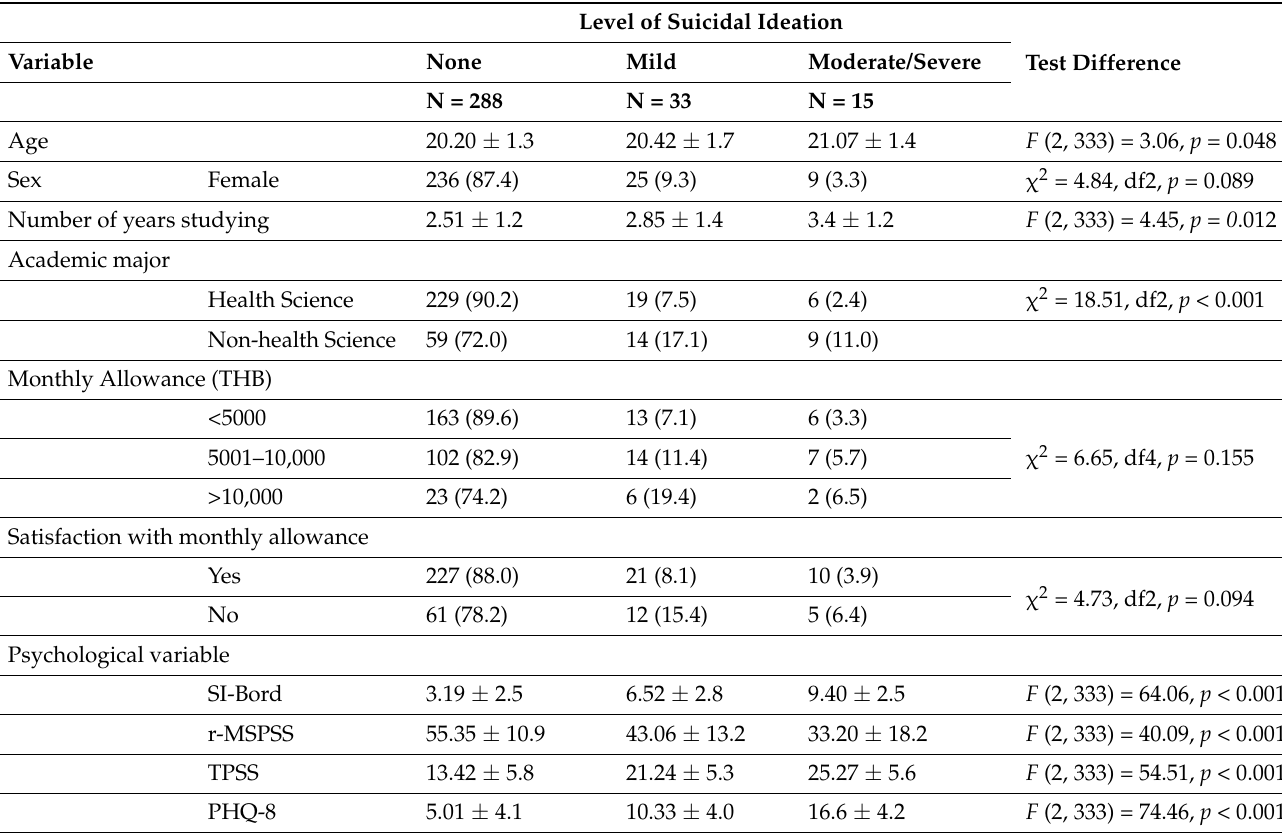
Table 2. Characteristics and demographic data of the participants according to the level of suicidal ideation.